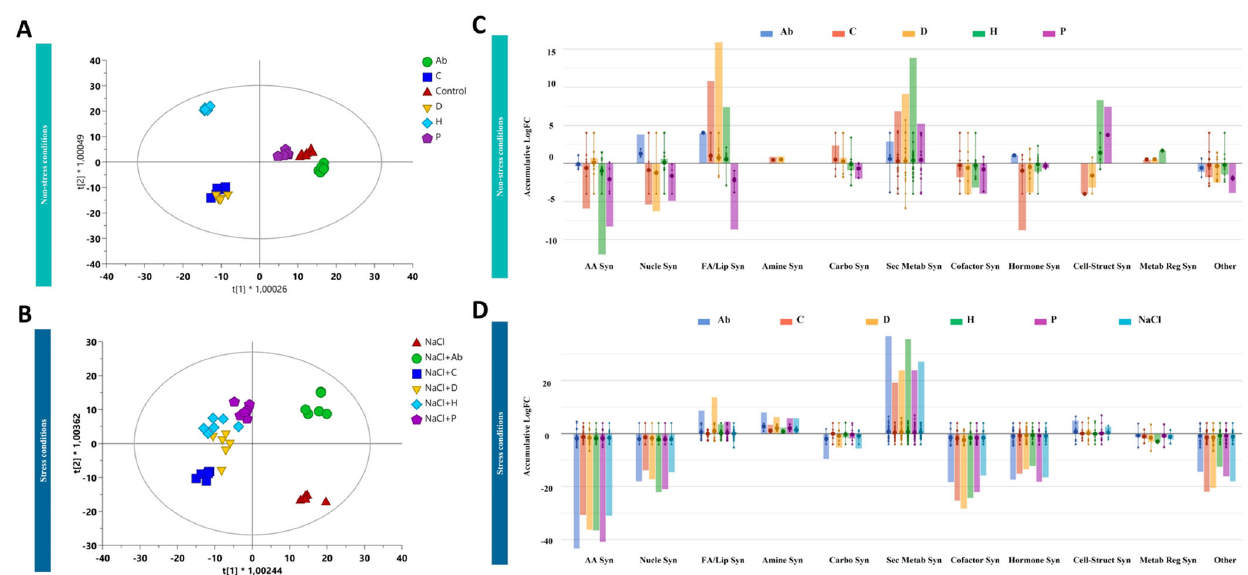
Figure 2. Supervised orthogonal projection to latent structures discriminant analysis (OPLS-DA) score plot built considering the metabolomic profile of tomato leaves under no-salt conditions (R 2 = 0.99; Q 2 = 0.8) ( A ) and high salt conditions (R 2 = 0.96; Q 2 = 0.8) ( B ). Biosynthetic processes affected by the biostimulants under low salt conditions ( C ) and high salt conditions ( D ). The metabolomic dataset produced through UHPLC-ESI/QTOF-MS was subjected to ANOVA and fold-change analysis ( p value < 0.05, Benjamini-Hochberg multiple testing correction) followed by Tukey post-hoc tests and differential metabolites were loaded into the PlantCyc Pathway Tool (https://www.plantcyc.org; accessed on 20 November 2021). The large dot represents the average (mean) of all data values for metabolites and the small dots represents the individual logFC for each metabolite. The abbreviated subcategories names on the x axis refer to: AA Syn: amino acids synthesis; Nucleo Syn: nucleosides and nucleotides synthesis; FA/lipids Syn: fatty acids and lipids synthesis; Amine Syn: amines and polyamines synthesis; Carbo Syn: carbohydrates synthesis; Sec Metab Syn: secondary metabolism synthesis; Cofactor Syn: cofactors, prosthetic groups, electron carriers, and vitamins; Hormone Syn: hormone synthesis; Cell-struct Syn: cell structures synthesis; Metab reg Syn: metabolic regulators synthesis; Other: other metabolites.